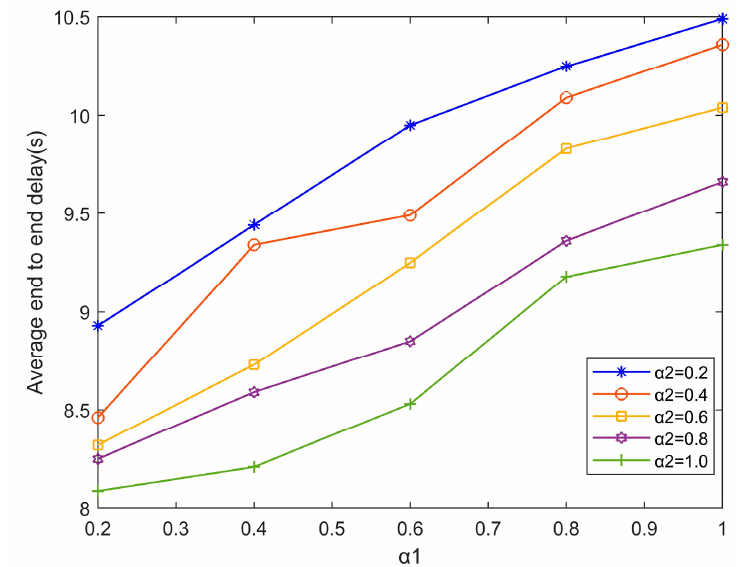
Figure 6. Average end-to-end delay of α 1 and α 2 (CR = 1000 m).